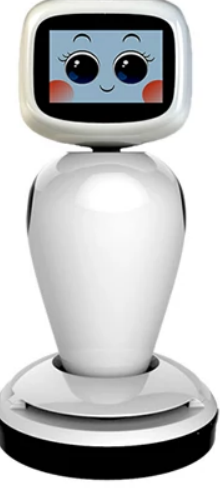
Figure 4. James Robot